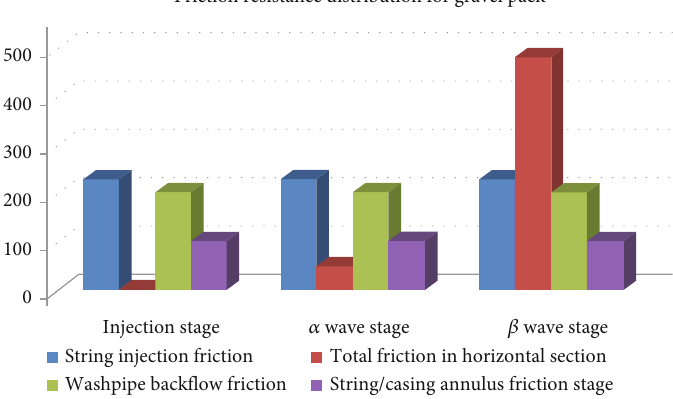
Figure 1: Comparison and analysis of 3-stage friction distribution of gravel packing in horizontal Wells.